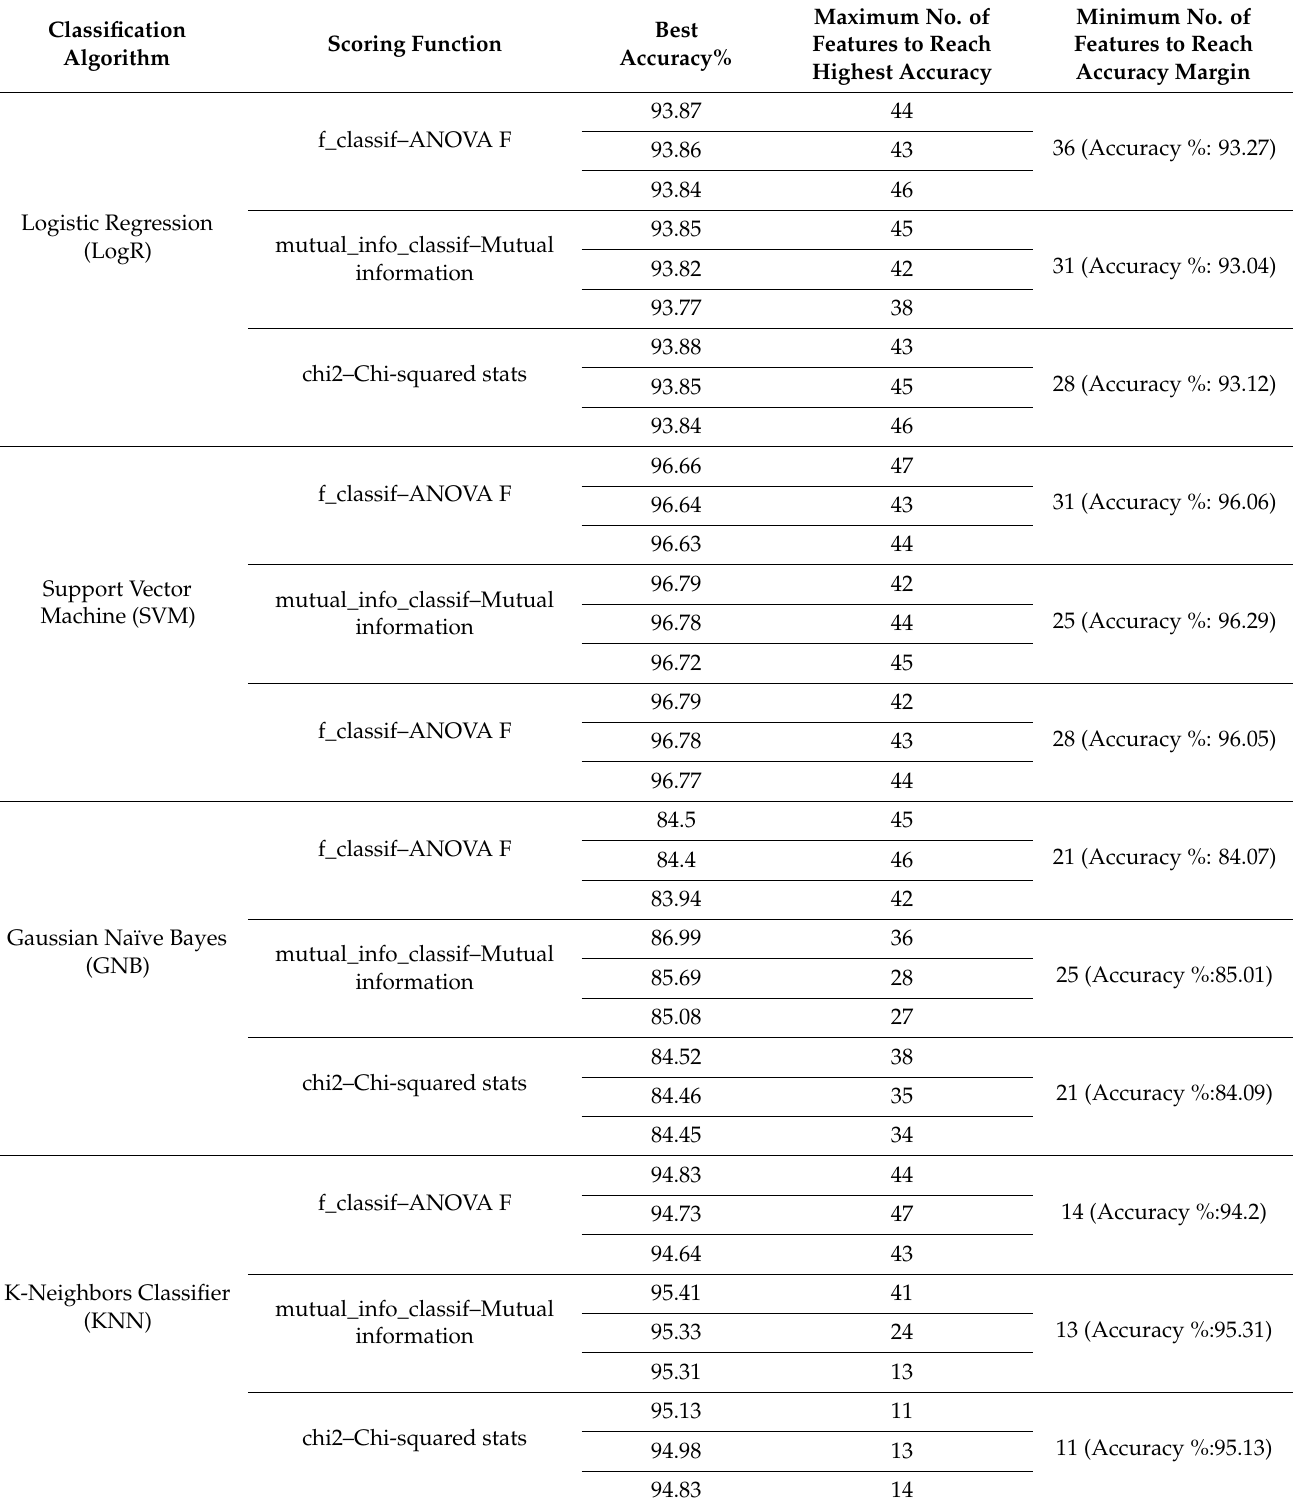
Table 15. Maximum and minimum number of features for optimal performance for